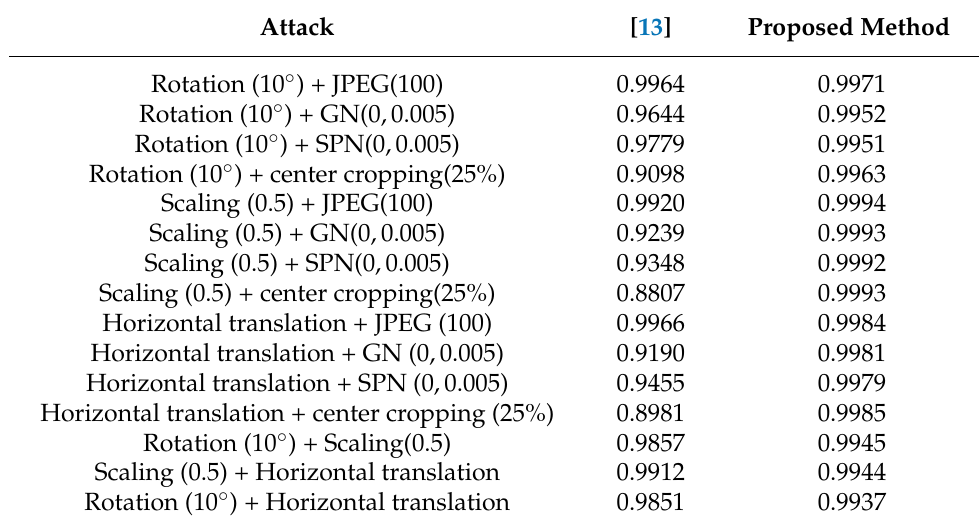
Table 9. Watermark robustness comparison in terms of NC against combined attacks.